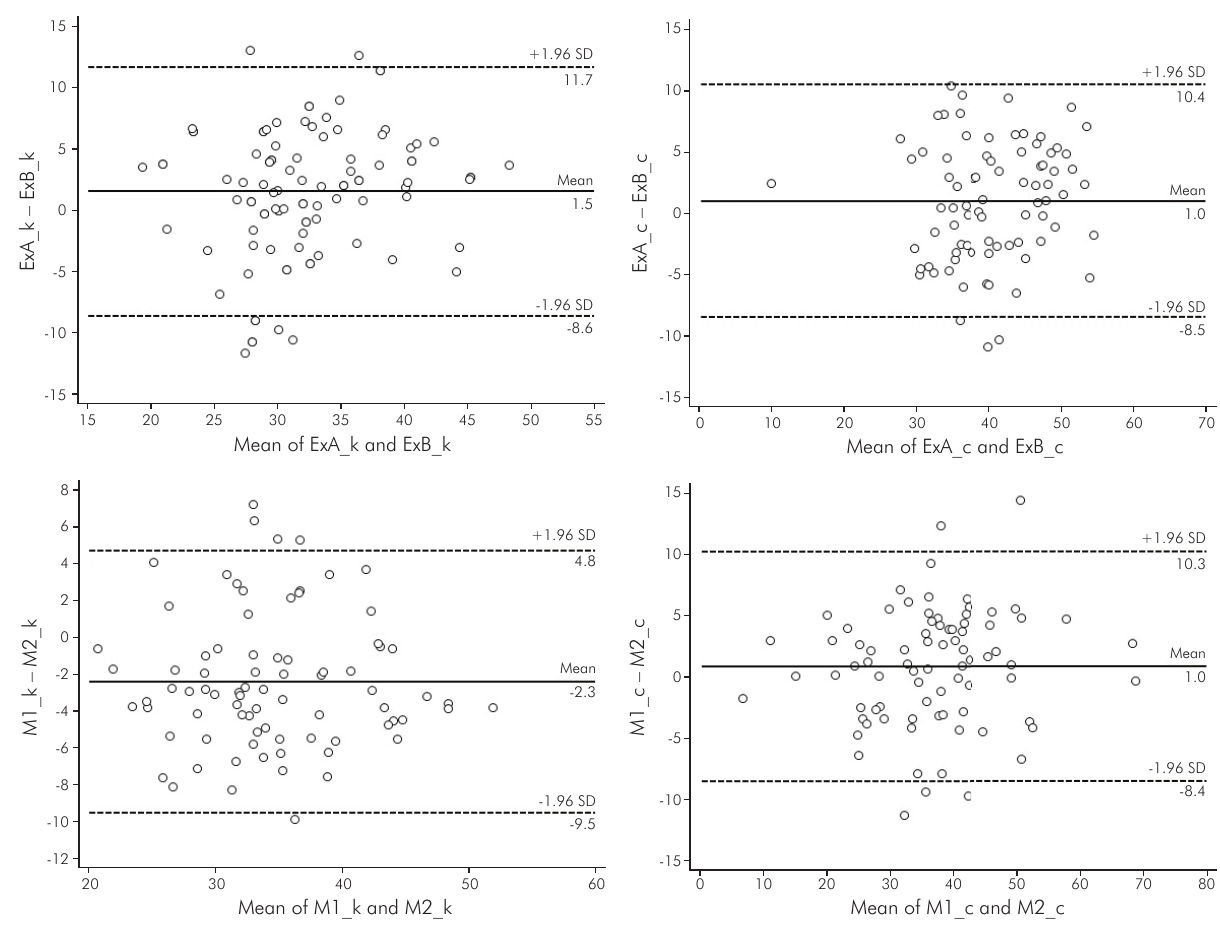
Figure 1. Bland Altman agreement analysis. Mean differences between both observers in Kvaal’s (A) and Cameriere’s (B) techniques; intra-observer agreement using Kvaal’s (C) and Cameriere’s (D)